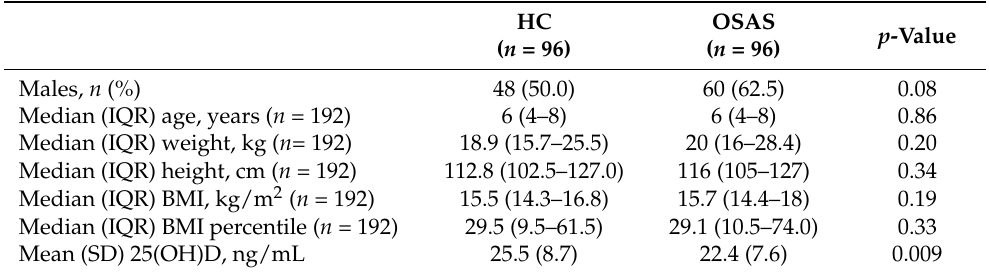
Table 2. Demographic and auxological data and serum 25(OH)D levels for OSAS patients and healthy controls (HC) matched by age.